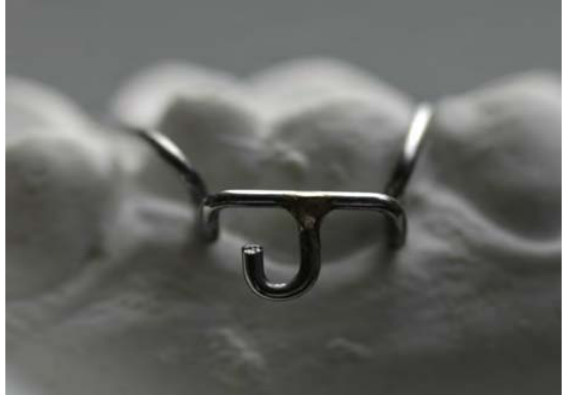
Fig. Adam’s clasp with J hook